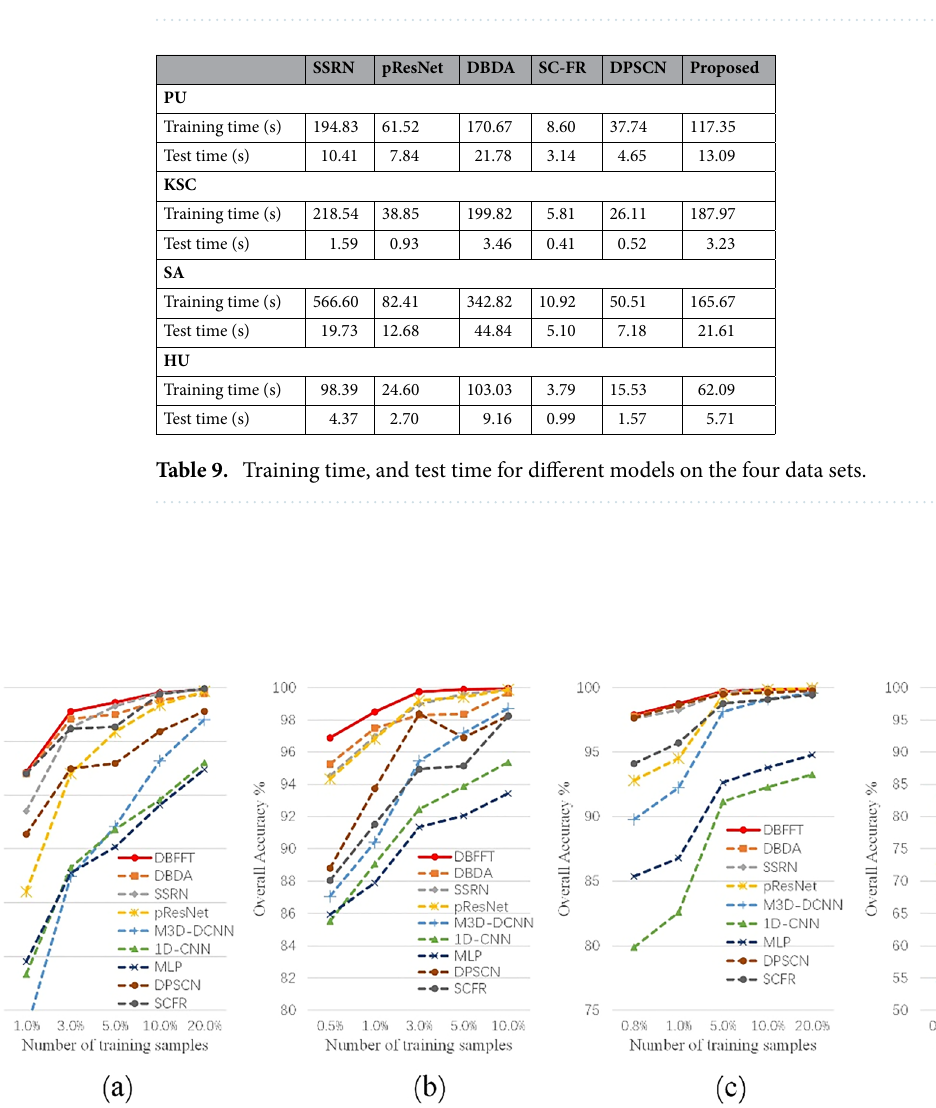
Figure 17. OA (%) of DBFFT with different number of training samples in the four datasets. ( a ) KSC dataset. ( b ) SA dataset. ( c ) PU dataset. ( d ) HU